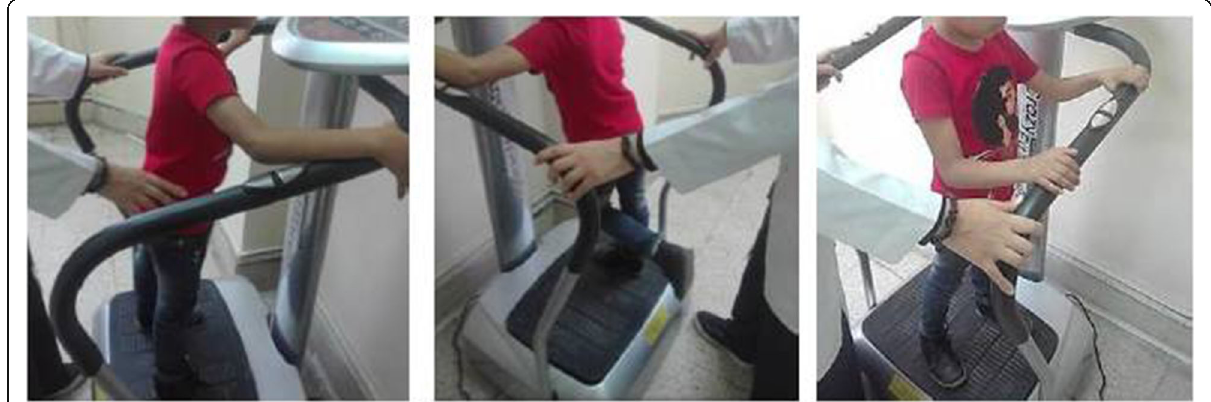
Fig. 2 Child positions during whole-body vibration